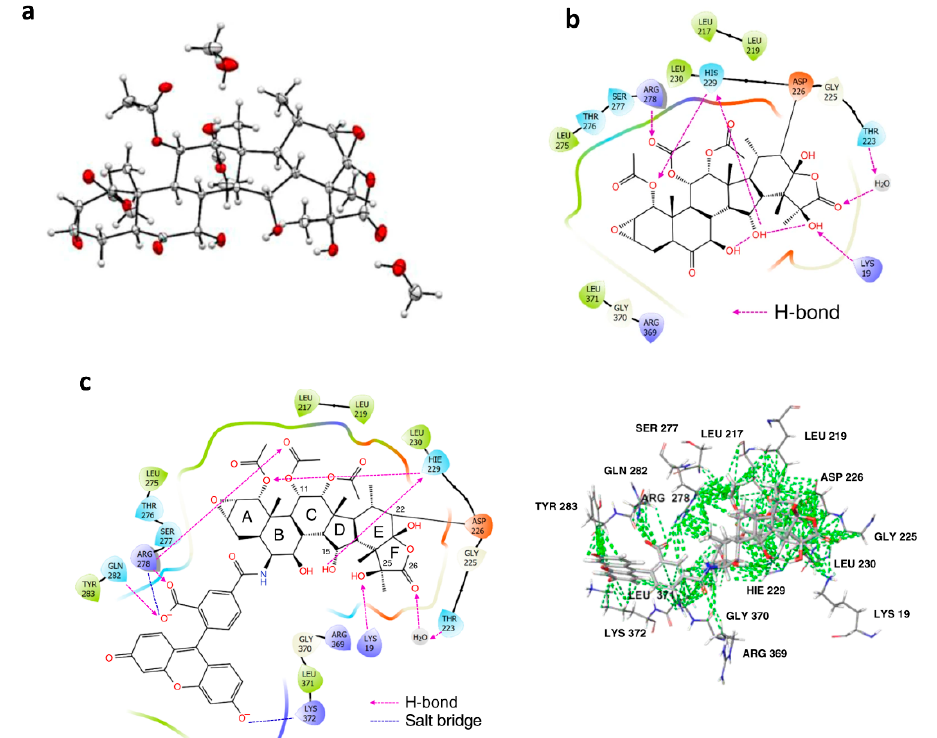
Figure 7. Proposed mechanism for the addition of Asp226 to taccalonolide AJ.